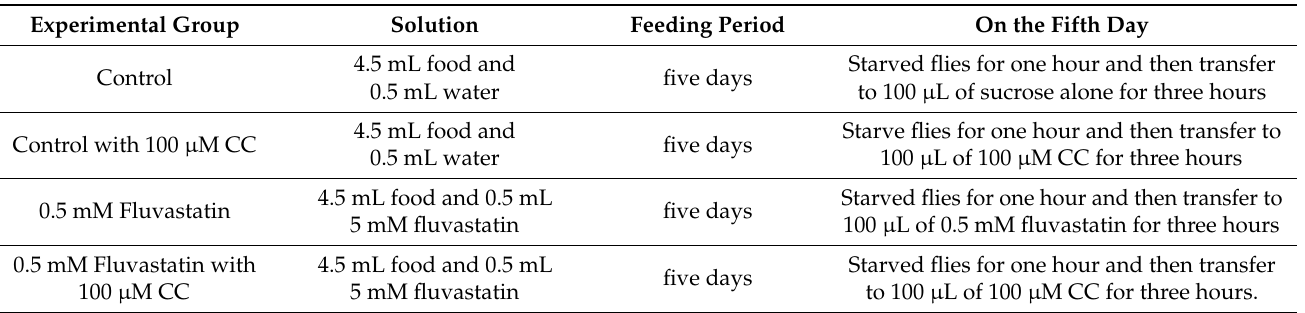
Table 3. Feeding pattern for fluvastatin group, fluvastatin with CC group, control group, and control with CC